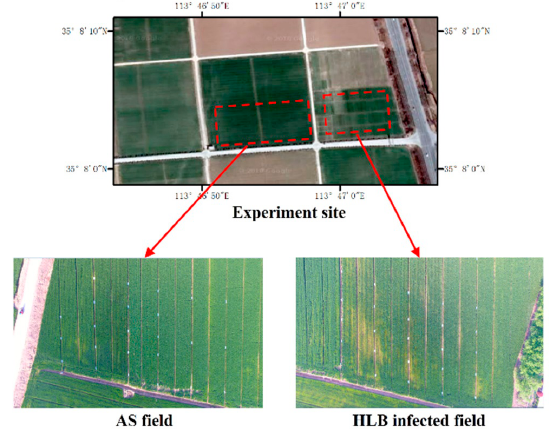
Figure 1 . General overview of the study location. Figure 1. General overview of the study